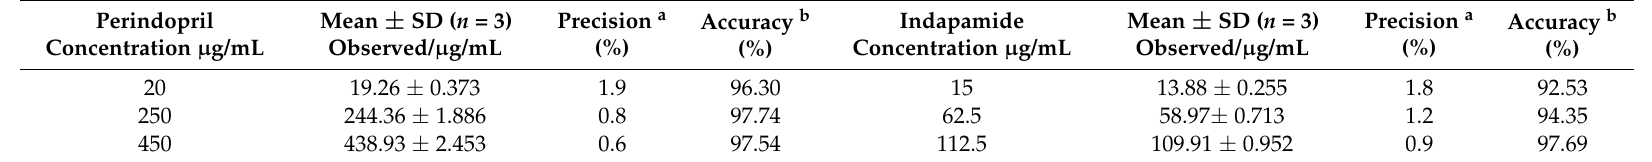
Table 4. Inter-assay precision and accuracy data for Perindopril and Indapamide determination in bulk powder using UPLC-UV. Perindopril Concentration µ